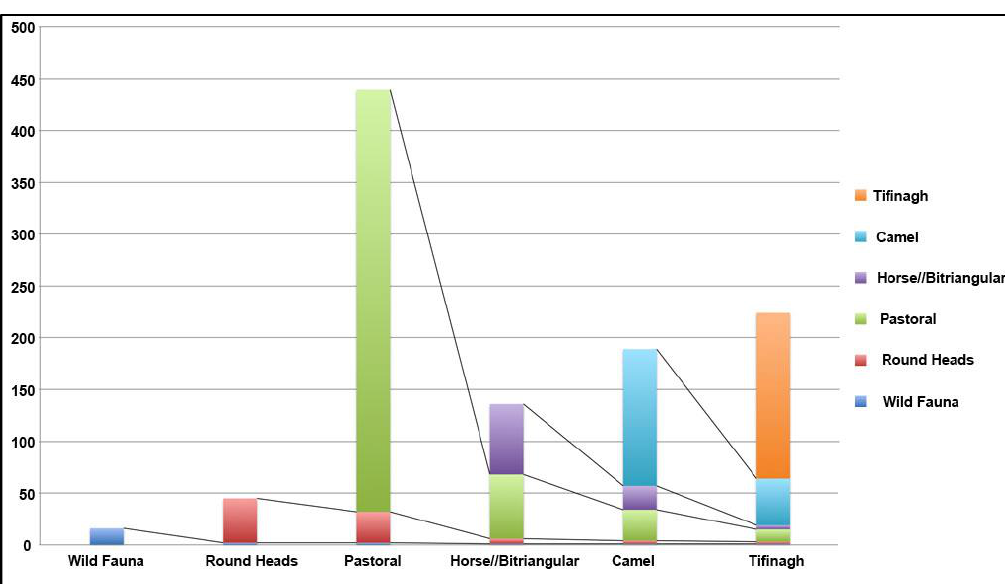
Figure 13. Quantity of rock art testimonies by style/phase, showing the continuity in use of sites from one style/phase to the